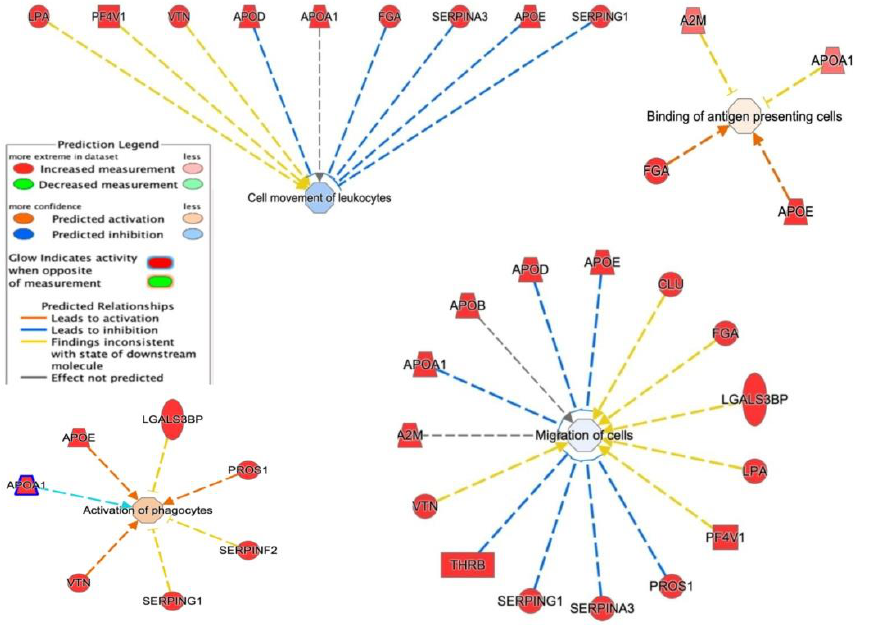
Figure 11. Network build-up from one of the most significant bio-functions: (1) activation of phagocytosis; (2) binding of antigen-presenting cells; (3) cell movement of leukocytes; (4) migration of cells.